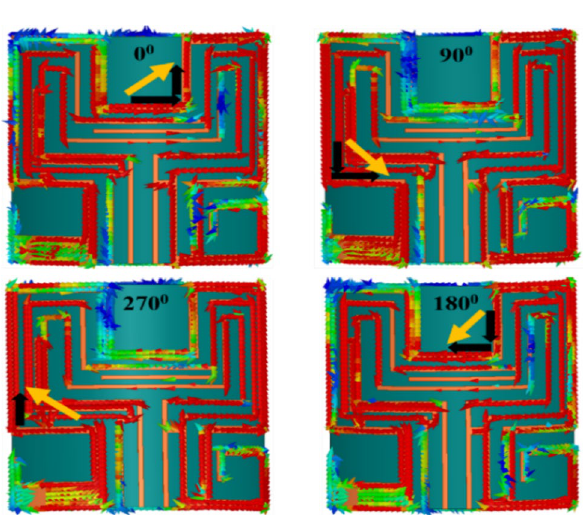
Figure 11. Surface current distribution on the proposed antenna at 2.45 GHz for ωt = 0°, 90°, 180° and